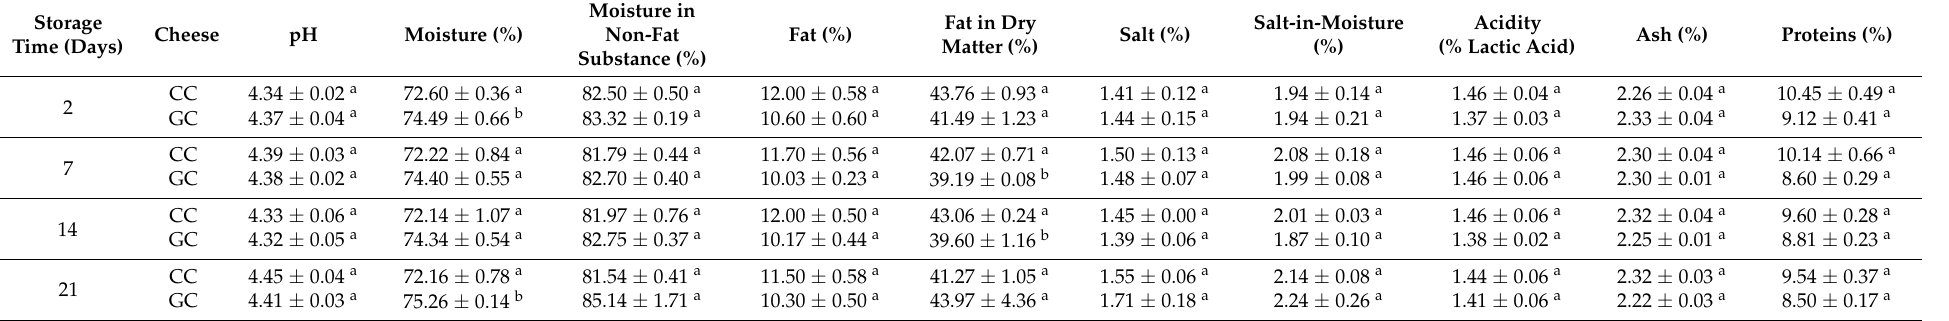
Table 1. Composition and physicochemical properties of GC and CC fresh spreadable cheeses made from ovine